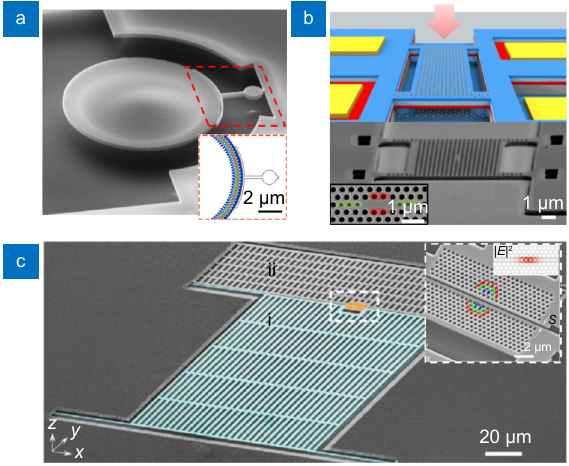
Fig. 28 | ( a ) Scanning electron micrograph along with the finite ele- ment model of the optical resonance of the optomechanical sensor ( b ) Sketch of the optomechanical sensor and the zoom-in SEM im- age showing the active part designed ( c ) A chip-scale optomechanic- al inertial sensor based on surface plasmon coupling. Figure repro- duced with permission from: (a) ref. 154 and (b) ref. 155 , Springer Nature; (c) ref. 156 , John Wiley and